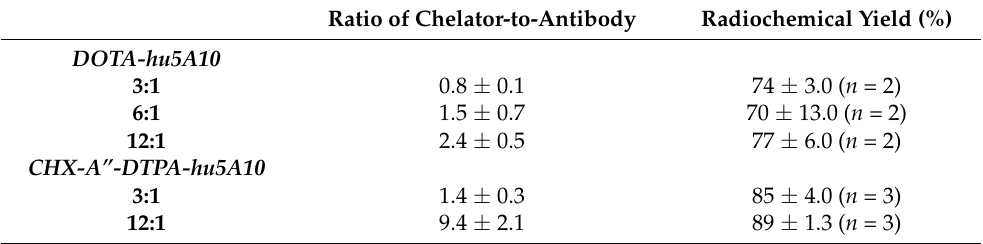
Table 2. Ratio of chelator-to-antibody and radiochemical yield for hu5A10 conjugated with the chelators CHX-A”-DTPA or